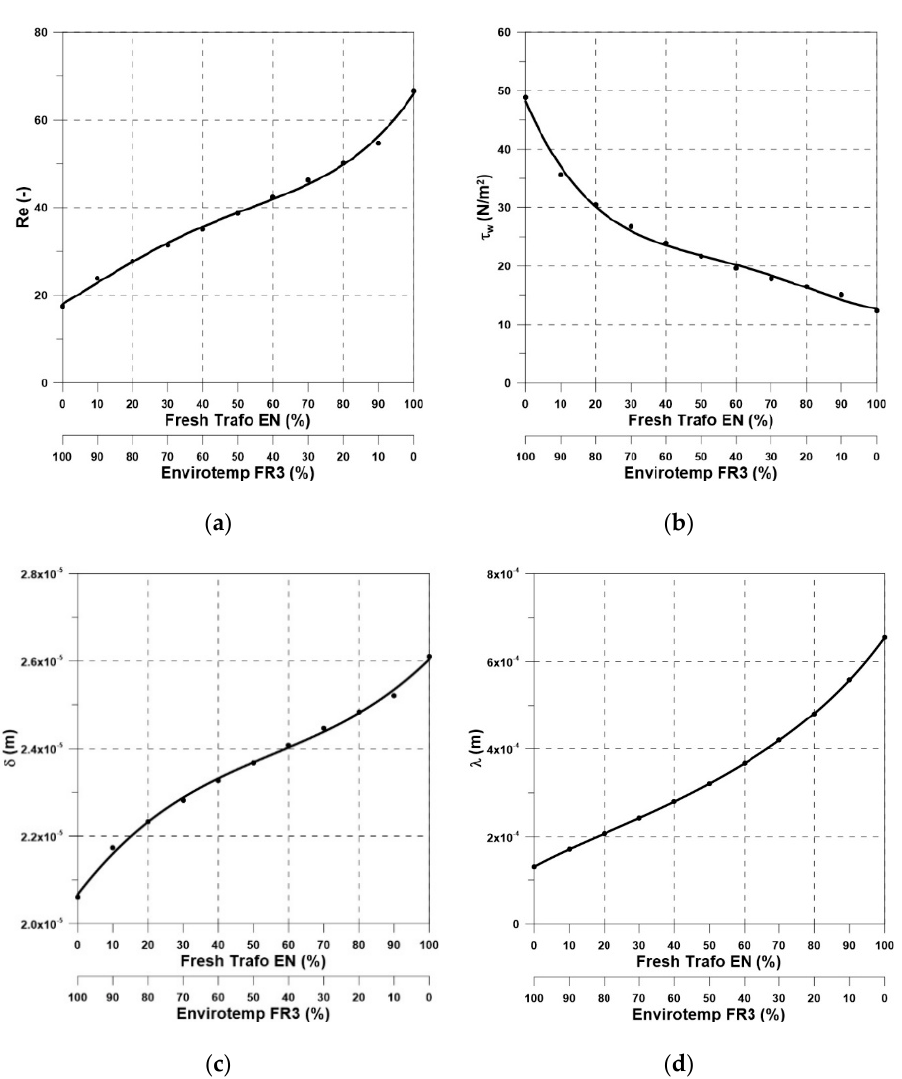
Figure 3. Selected parameters of the Abedian–Sonin model vs. mixture content: ( a ) Reynolds number; ( b ) shearing stress; ( c ) laminar sublayer thickness; ( d ) Debye length.